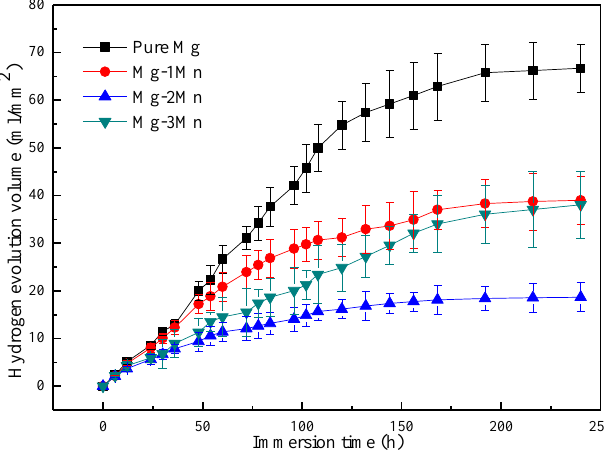
Figure 6. The hydrogen evolution volume of rapid laser-melted Mg- x Mn alloys as function of immersion time.